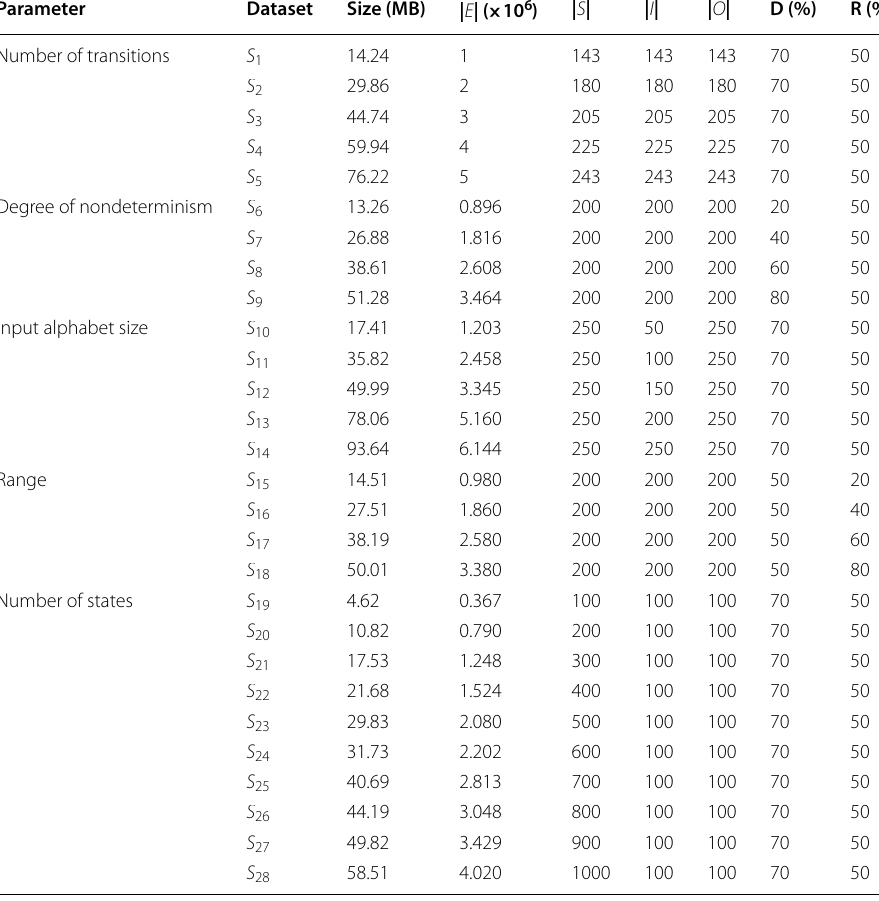
Table 1 Datasets used in different experiments